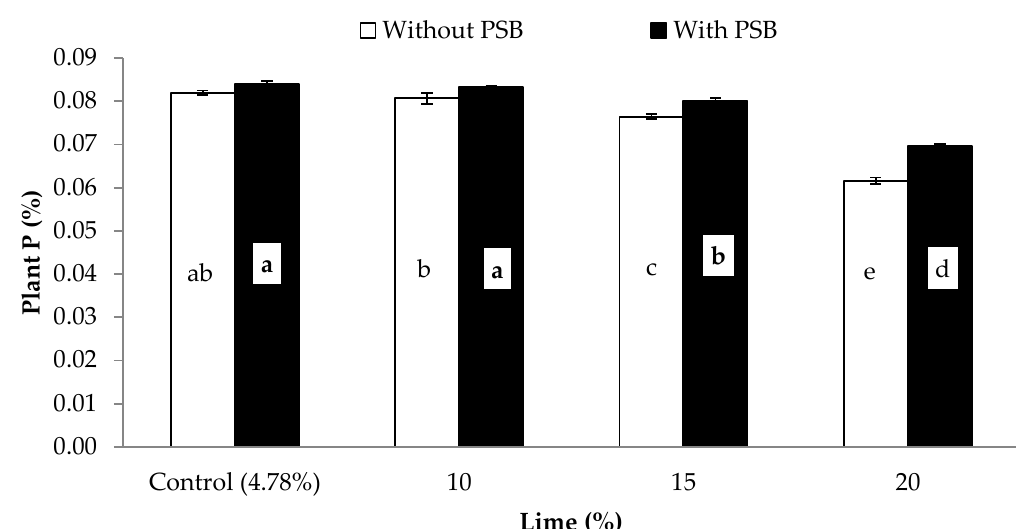
Figure 5. Associative effect of PSB and lime on maize P concentration (%).Bars sharing letters are statistically comparable at p < 0.05 according to least significance difference (LSD) test. Error bars show standard error (n = 3).